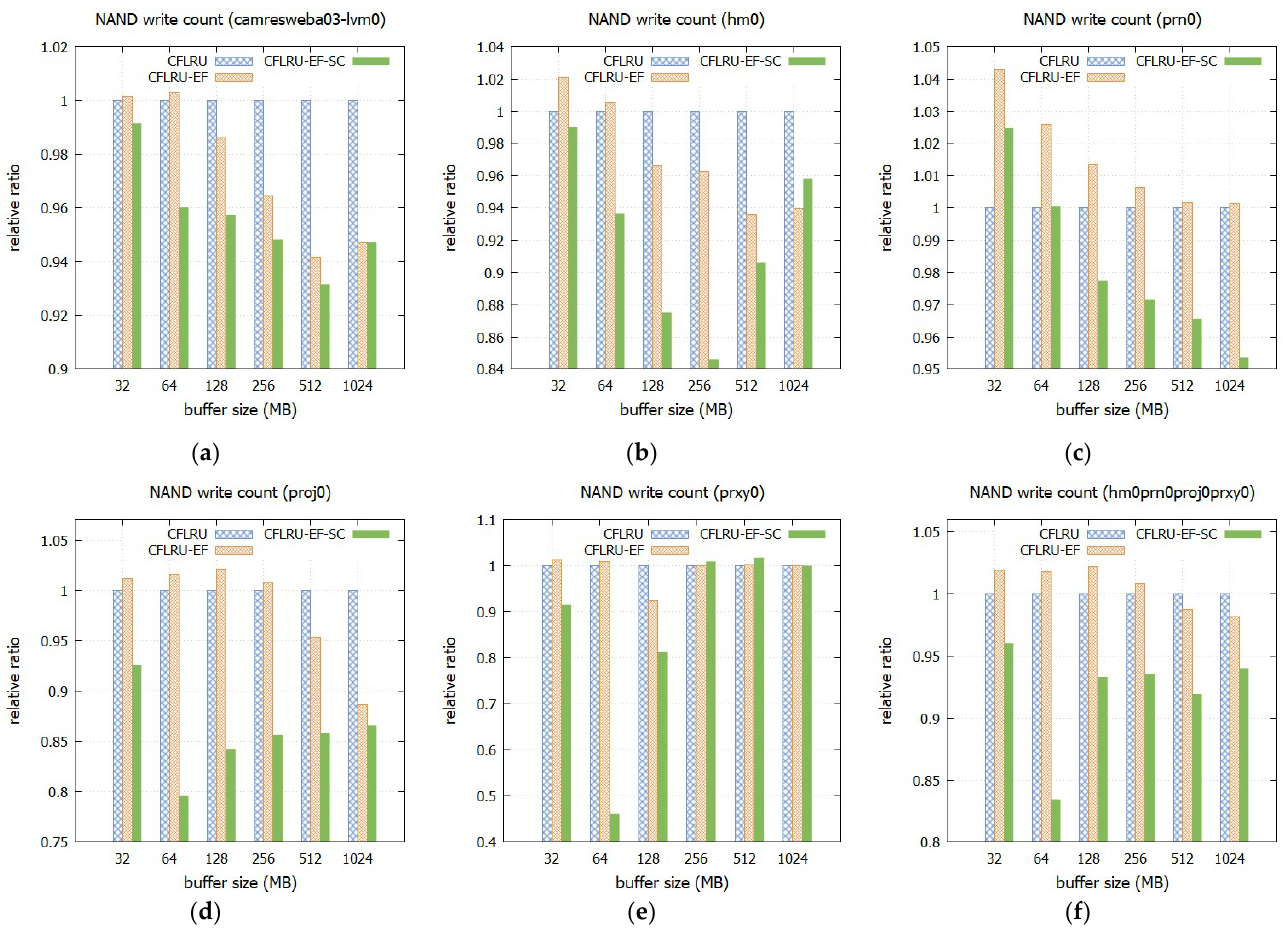
Figure 6. The number of NAND write operations. ( a ) camresweba03-lvm0; ( b ) hm0; ( c ) prn0; ( d ) proj0; ( e ) prxy0; ( f ) hm0prn0proj0prxy0.